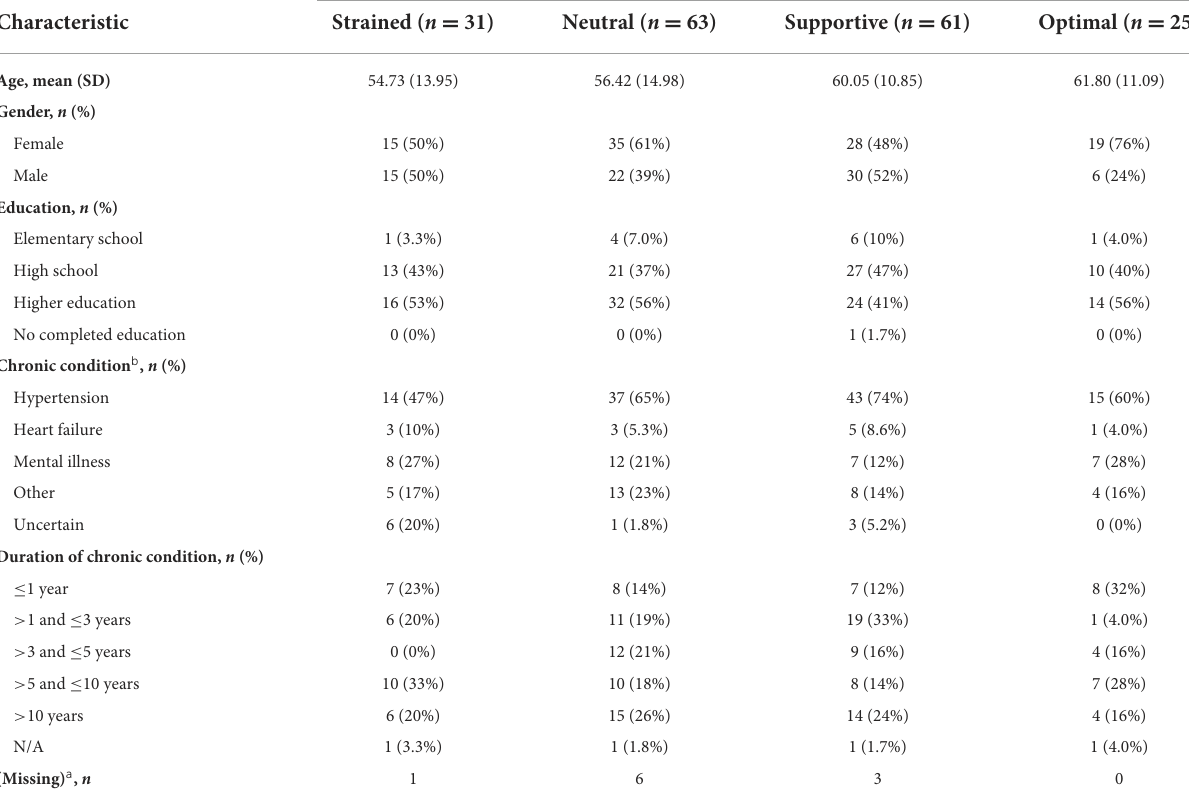
TABLE 4 Background variables of the profiles at T1 ( N = 170 a